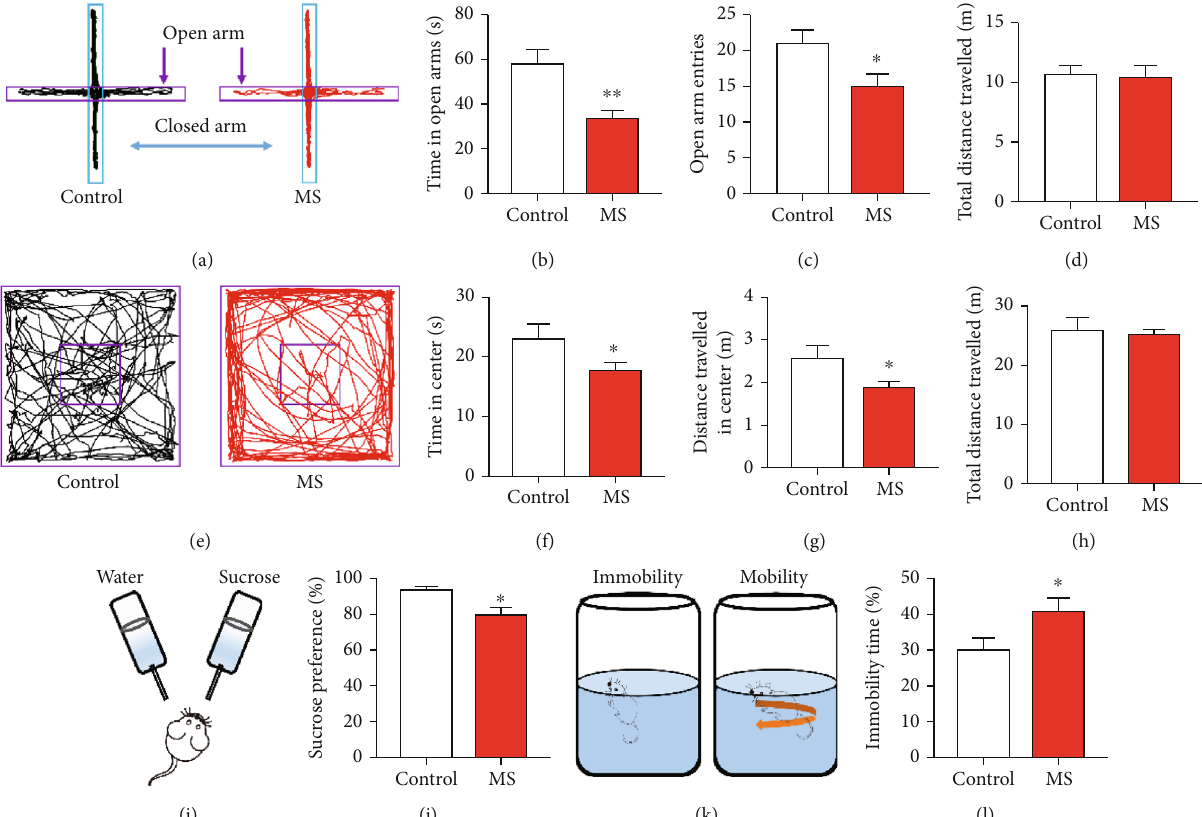
Figure 2: Mice experiencing neonatal MS showed anxiety- and depression-like behaviors. (a) Representative activity traces of control and MS mice in the elevated plus maze. (b – d) The duration spent in the open arms ( t -test, t = 3 : 06 , P < 0 : 01 ) and the times of entry into the open arms ( t -test, t = 2 : 48 , P < 0 : 05 ) were signi fi cantly reduced in the MS mice compared with the control mice ( n = 8 per group), with no signi fi cant di ff erence in the total distances travelled between the control and MS mice ( t -test, t = 0 : 28 , P = 0 : 783 , n = 8 per group). (e) Schema of the open fi eld and the representative activity traces in control and MS mice. (f – h) The duration in the central area ( t -test, t = 2 : 13 , P < 0 : 05 ) and the courses in the central area ( t -test, t = 2 : 28 , P < 0 : 05 ) were signi fi cantly reduced in the MS group compared with the control group ( n = 8 per group); similarly, there was an insigni fi cant di ff erence in the total distances travelled between the control and MS mice ( t -test, t = 0 : 46 , P = 0 : 653 , n = 8 per group). (i) Schematic diagram of the sucrose preference test. (j) The percentage of the sucrose intake volume over the total fl uid intake volume in the MS mice was signi fi cantly smaller than that in the control mice ( t -test, t = 2 : 57 , P < 0 : 05 , n = 8 per group). (k) Schematic representation of mobility and immobility in the forced swim test. (l) The percentage of immobility duration over the total time in the MS mice was signi fi cantly greater than that in the control mice ( t -test, t = 2 : 36 , P < 0 : 05 , n = 8 per group). Data are expressed as mean ± SEM ; ∗ P < 0 : 05 and ∗∗ P < 0 : 01